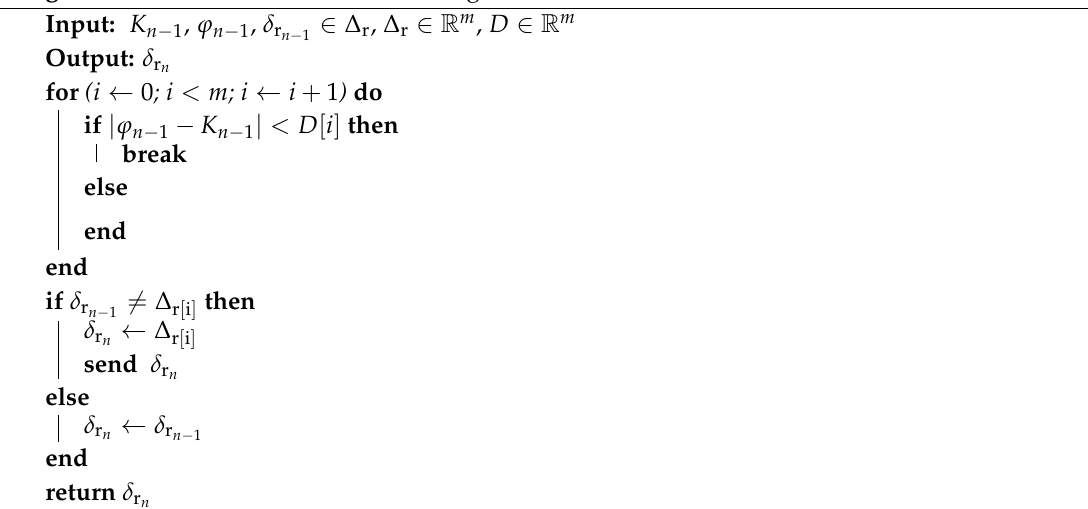
Algorithm 4: Reduction Parameter Change